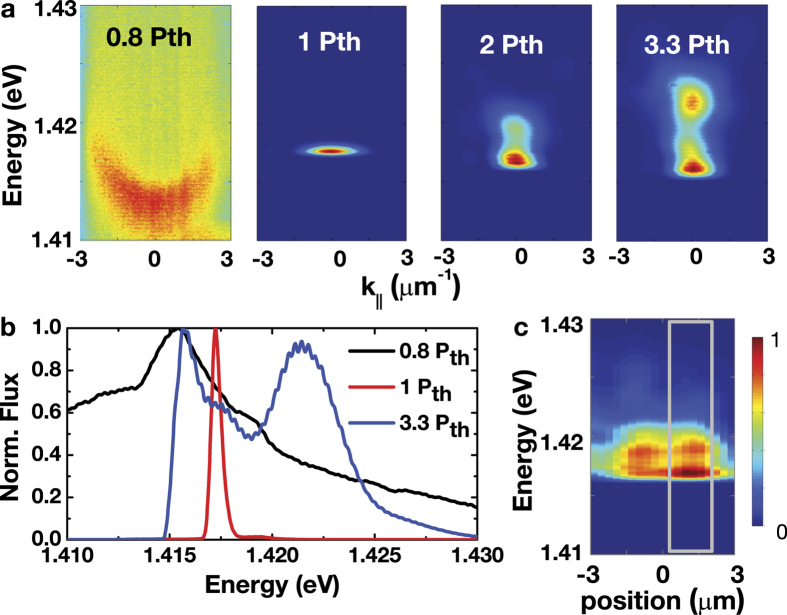
Two-state lasing in a microcavity.(a) Angularly resolved (k-space) imaging spectra of the co-circular (σ+/σ+) emission component at P = 0.8, 1.0, 2.0, and 3.3 Pth. (b) Time-integrated spectra at 0.8 (solid black line), 1.0 (solid red line) and 3.3 Pth (solid blue line). (c) Real-space (r-space) imaging spectra at 2.0 Pth. The k-space spectra shown in (a,b) are measured through a pinhole, as represented by the gray box.